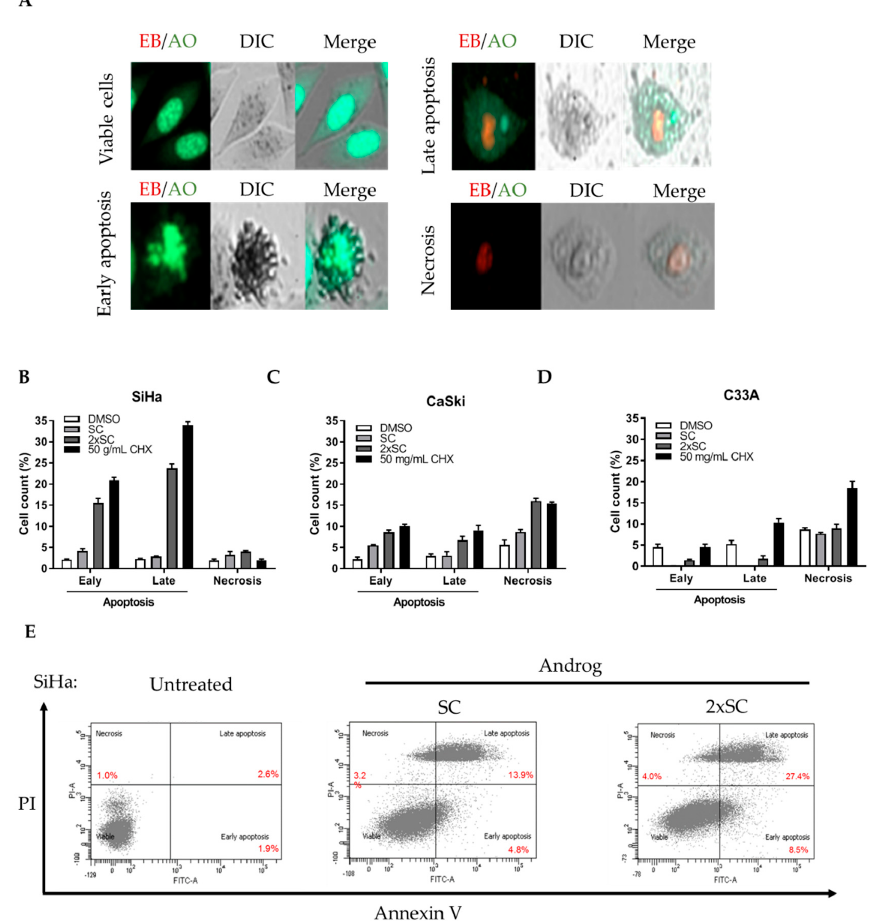
Figure 2. Androg induced apoptosis in HPV16-positive cervical cancer cell lines. ( A ) EB/AO staining of cervical cancer cell lines after treatment with Androg. Red signals (from ethidium bromide, EB) indicated cells that lost their membrane in- tegrity, green signals (from acridine orange, AO) indicated a nucleic acid selective fluorescent cationic dye. ( B – D ) Apop- tosis in SiHa cells ( B ), CaSki cells ( C ), and C33A cells ( D ) after Androg treatment for 48 h. DMSO and CHX (cycloheximide) were used as vehicle and positive controls for programed cell death. ( E ) The analysis of flow cytometry with Annexin V/PI labeling exhibited the percentages of cells in early and late apoptosis after Androg treatment. SC, sub-cytotoxic concen- tration; 2xSC, 2-fold of sub-cytotoxic